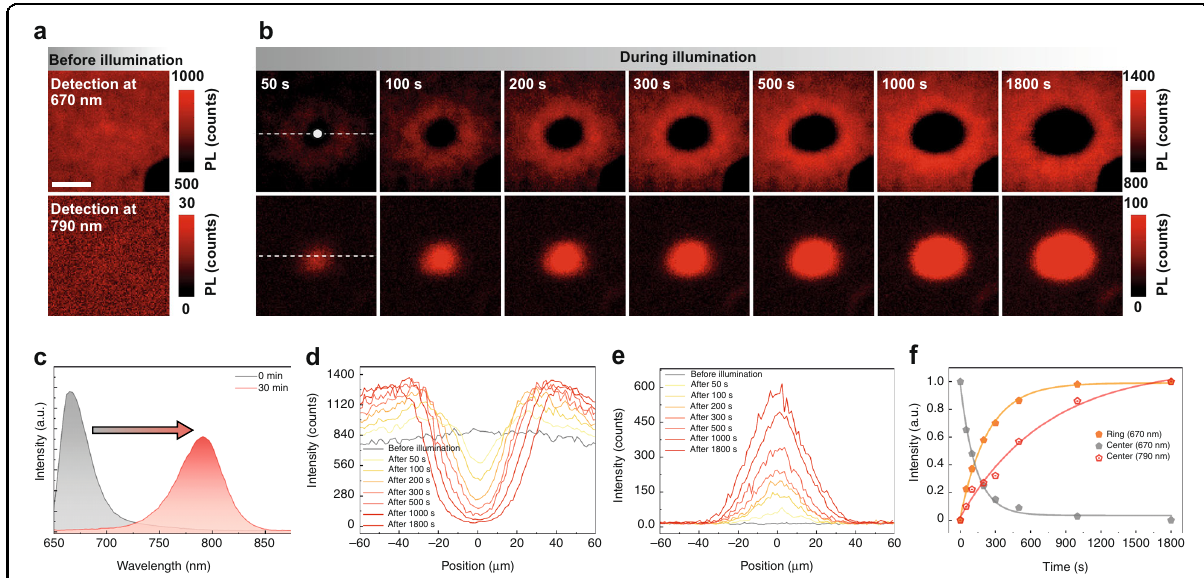
Fig. 1 Time evolution of the light-induced spatial variation in PL for a MA 0.17 FA 0.83 Pb(I 0.5 Br 0.5 ) 3 thin- fi lm sample. a PL mapping at 670 and 790 nm before local illumination (The dark area at the lower right corner is due to a marker). The scale bar is 40 μ m. b PL mapping at 670 nm (top row) and 790 nm (bottom row) of the same area as in ( a ) after the center of the area being illuminated for different effective illumination times. The small dot indicates the pump beam size. c PL spectra at the initial state and after illumination over 30 min at the center. d , e Time-dependent PL spatial pro fi les taken along the white dashed lines from PL maps of 670 and 790 nm in ( b ), respectively. f The normalized time dependence of 670 nm PL intensity at the ring and center from ( d ), and 790 nm PL intensity at the center from ( e ). Symbols are data points, and lines are fi tting